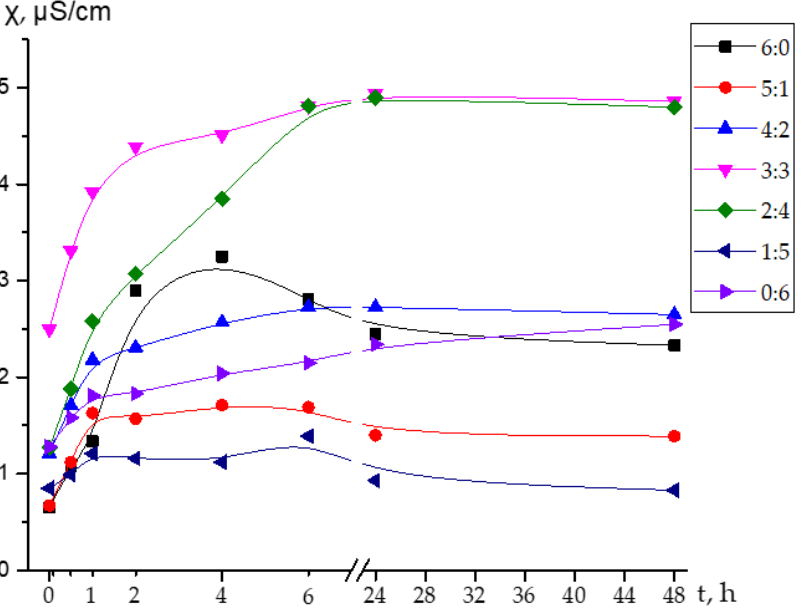
Figure 7. Changes in specific electrical conductivity of a solution as a function of time in the presence of ion exchangers during the activation process.